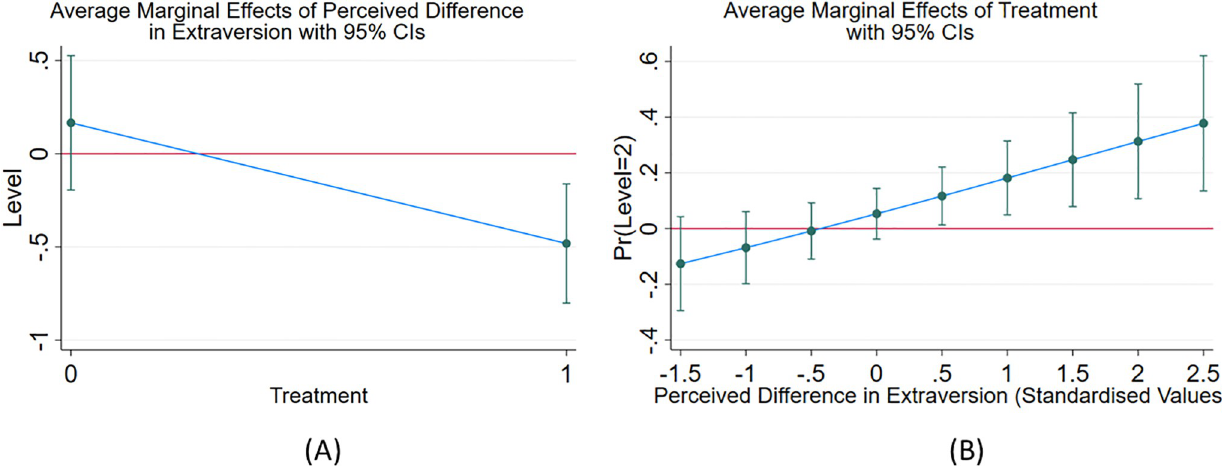
Fig 4. Perceived differences in the players and their partners’ extraversion, and level-k choices made. (A) Effect of perceived difference in extraversion on level choice in control and treatment groups. The figure shows that perceived difference in extraversion has a significant negative effect on the player’s level-k choice in the treatment group. (B) shows that the effect of small talk treatment on probability of best responding to the distribution of level beliefs increases as the perceived difference in extraversion increases.